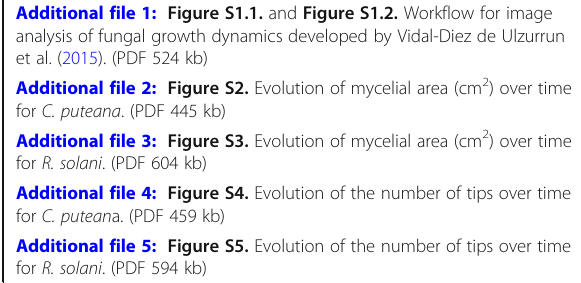
Additional file 1: Figure S1.1. and Figure S1.2. Workflow for image analysis of fungal growth dynamics developed by Vidal-Diez de Ulzurrun et al. (2015). (PDF 524 kb) Additional file 2: Figure S2. Evolution of mycelial area (cm 2 ) over time for C. puteana . (PDF 445 kb) Additional file 3: Figure S3. Evolution of mycelial area (cm 2 ) over time for R. solani . (PDF 604 kb) Additional file 4: Figure S4. Evolution of the number of tips over time for C. putean a. (PDF 459 kb)